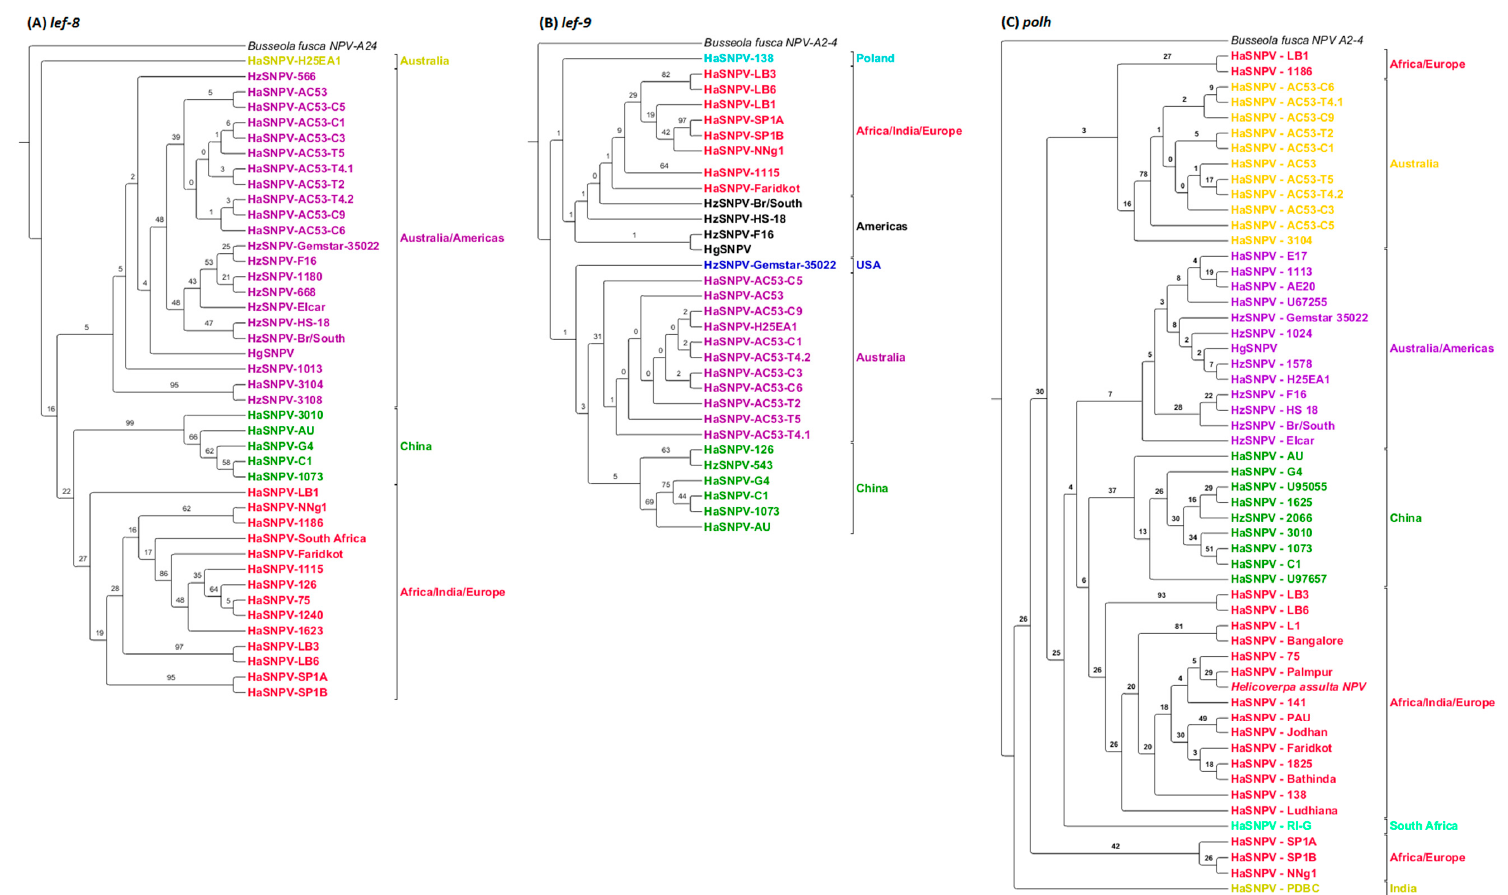
Figure 5. All trees have not been collapsed, due to poor bootstrapping support, and would not be differentiated otherwise, and have all been rooted to Busseola fusca NPV A2 ‐ 4. ( A ) The geographic relationships of lef ‐ 8 have at least three clusters, Africa/India/Europe (red), China (green), Australia/Americas (purple) and the Australian H25EA1 isolate (yellow ‐ green); ( B ) The geographic relationships of lef ‐ 9 have at least four clusters, Africa/India/Europe (red), Poland (aqua), the United States of America (blue) and North and South America (black), Australia (purple) and China (green); ( C ) The geographic relationships of polh have at least four clusters, India (yellow ‐ green), Africa/Indian/Europe (red), China (green), South Africa (light green), Australia (yellow) and Australia/Americas (purple).